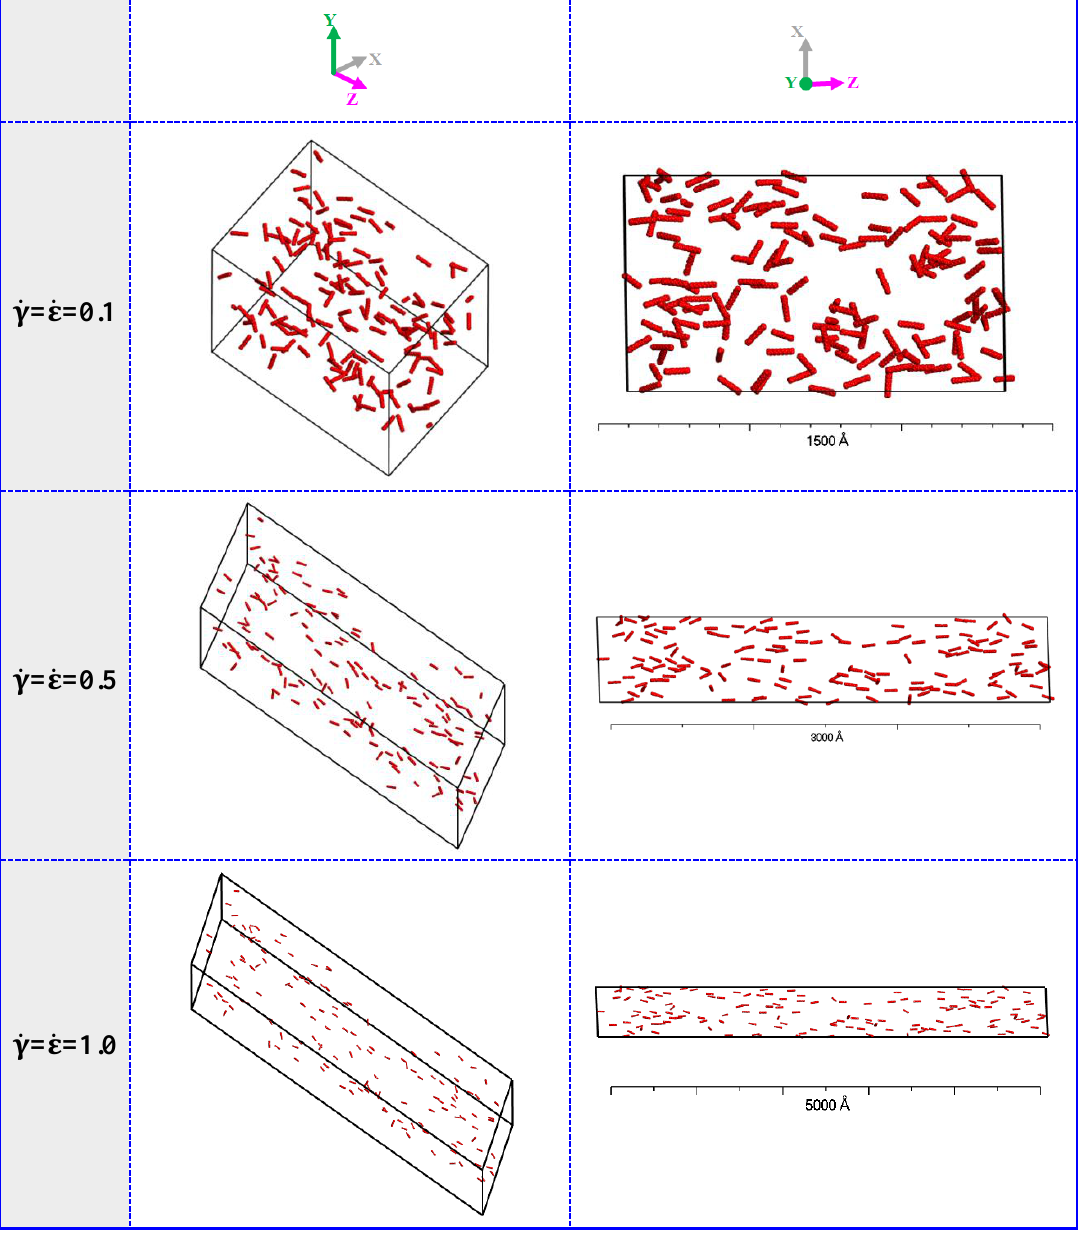
Figure 2. The structure of CNTs/UHMWPE composites at 10% CNTs in response to different extensional-shear coupled rates. The beads of PE are not displayed in this study and beads of CNTs are displayed in CPK style with a CPK scale of 2.5 for